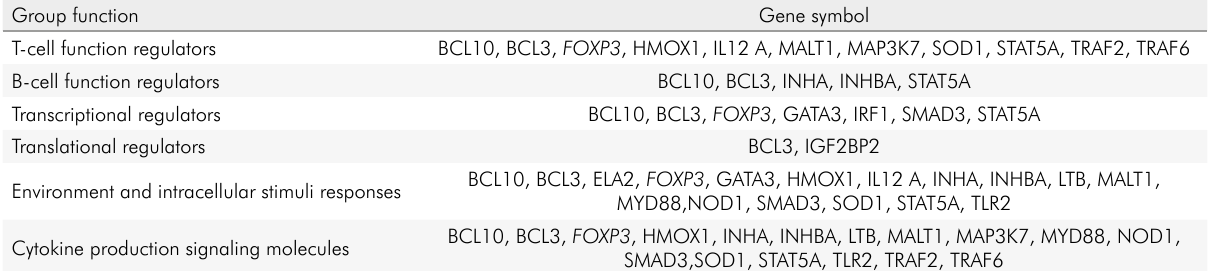
Table 2. Composition of Epitect Methyl II Signature Human Cytokine Production PCR Array (SABiosciences, Qiagen). Group function